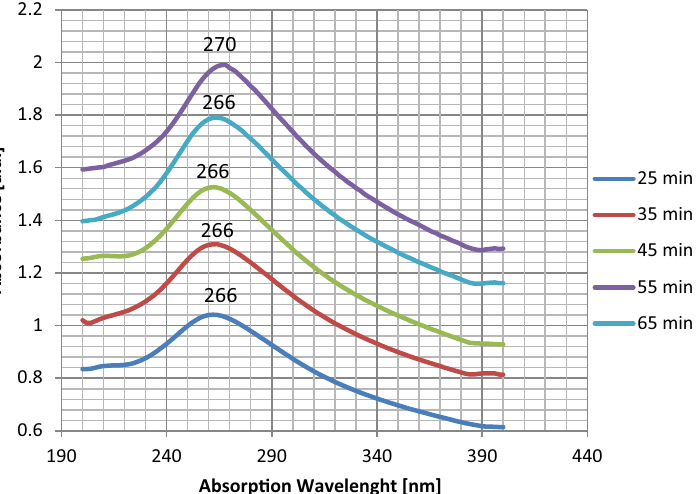
0.50.70.91.11.31.51.71.92.1